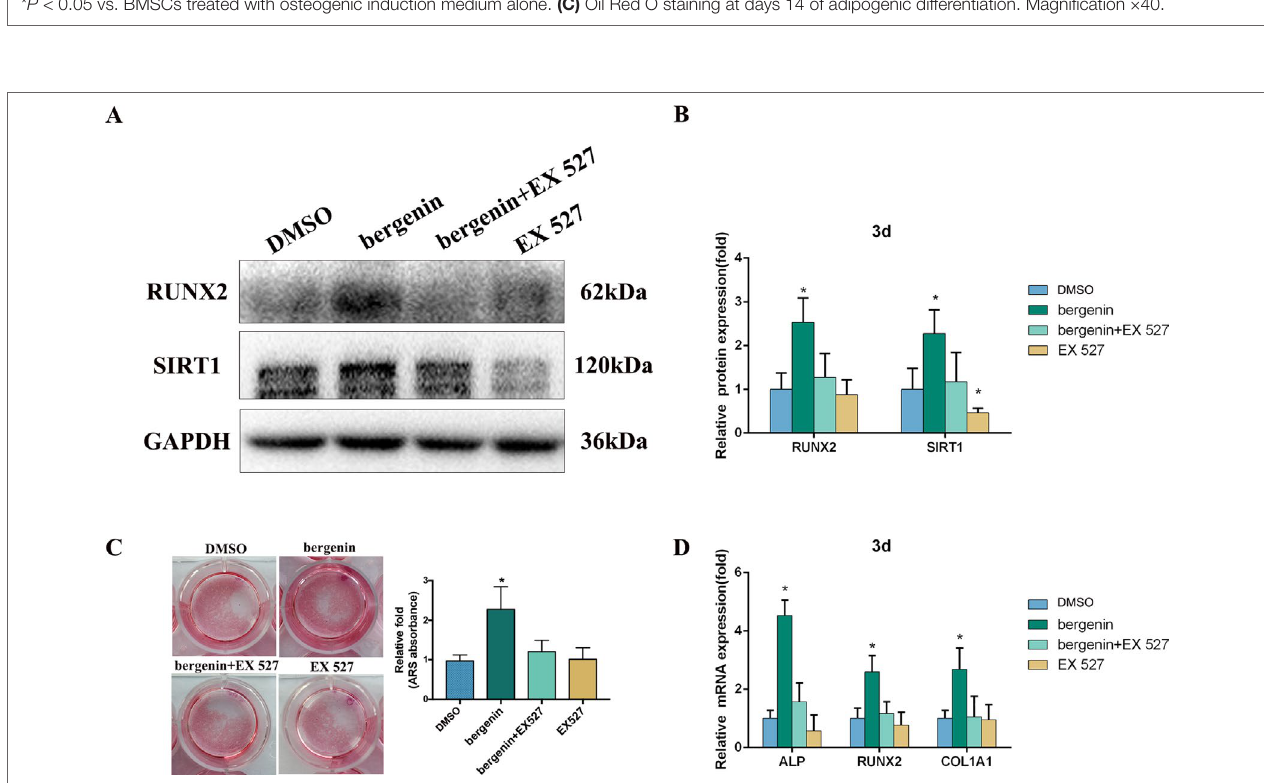
FIGURE 4 | Effects of a SIRT1-specific inhibitor (EX 527) on the enhanced expression of an osteoblast-specific gene of bone marrow mesenchymal stem cells by Bergenin. (A and B) The expression of RUNX2 and SIRT1 in blank, control + EX 527, Bergenin (10 μM), and Bergenin (10 μM) + EX 527 groups was determined by Western blot analysis. EX 527 (10 μM) was applied for 1 h, followed by culture in osteogenic induction medium with Bergenin for 3 days. Protein expression levels were normalized to glyceraldehyde-3-phosphate dehydrogenase. Data are expressed as the mean ± standard deviation (SD) of three independent experiments, and one of three independent experiments is shown. Data are expressed as the mean ± SD. * P < 0.05 vs. group with osteogenic induction medium alone. (C) Alizarin red staining and quantification of mineralization at day 12 of osteogenic differentiation. (D) The mRNA expression of RUNX2, ALP, and COL1A1 in blank, control + EX 527, Bergenin (10 μM), and Bergenin (10 μM) + EX 527 groups was determined by quantitative reverse transcription polymerase chain reaction. EX 527 (10 μM) was applied for 1 h, followed by culture in osteogenic induction medium with Bergenin for 3 days. mRNA expression levels were normalized to GAPDH. * P < 0.05 vs. BMSCs treated with osteogenic induction medium